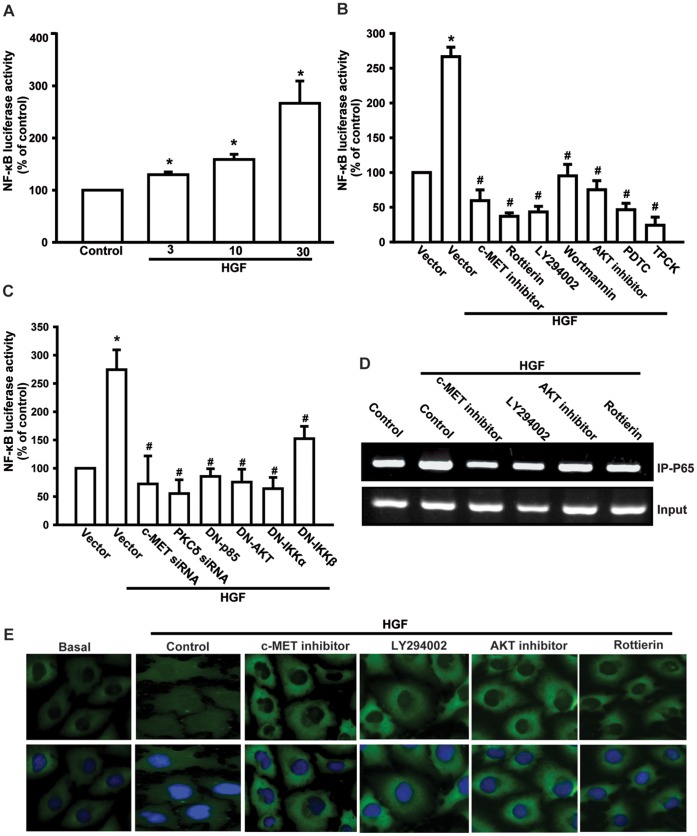
The PI3K/Akt/PKCδ pathway is involved in HGF-mediated NF-κB activation and MMP-2 expression.JJ012 cells were incubated with HGF for 24 h (A) or pretreated with c-Met inhibitor, Ly294002, wortmannin, Akt inhibitor, rottlerin, PDTC, and TPCK for 30 min (B) or were transfected with c-Met siRNA, PKCδ siRNA, p85 mutant, Akt mutant, IKKα mutant, and IKKβmutant (C) before exposure to HGF. NF-κB luciferase activity was measured, and the results were normalized to the β-galactosidase activity and expressed as mean ± S.E.M. for 3 independent experiments, each performed in triplicate. (D) JJ012 cells were pretreated with c-Met inhibitor, Ly294002, wortmannin, Akt inhibitor, or rottlerin, then stimulated with HGF for 120 min, before a chromatin immunoprecipitation assay was performed. Chromatin was immunoprecipitated with anti-p-65. One percentage of the precipitated chromatin was assayed to verify equal loading (input). (E) Upper panel, p65 staining; lower panel, p65 staining merged with nucleus staining. JJ012 cells were pretreated with c-Met inhibitor, Ly294002, wortmannin, Akt inhibitor, or rottlerin, and then stimulated with HGF for 120 min, and p65 immunofluorescence staining then examined. Results are expressed as mean ± S.E. *p<0.05 compared with control; #p<0.05 compared with HGF-treated group.